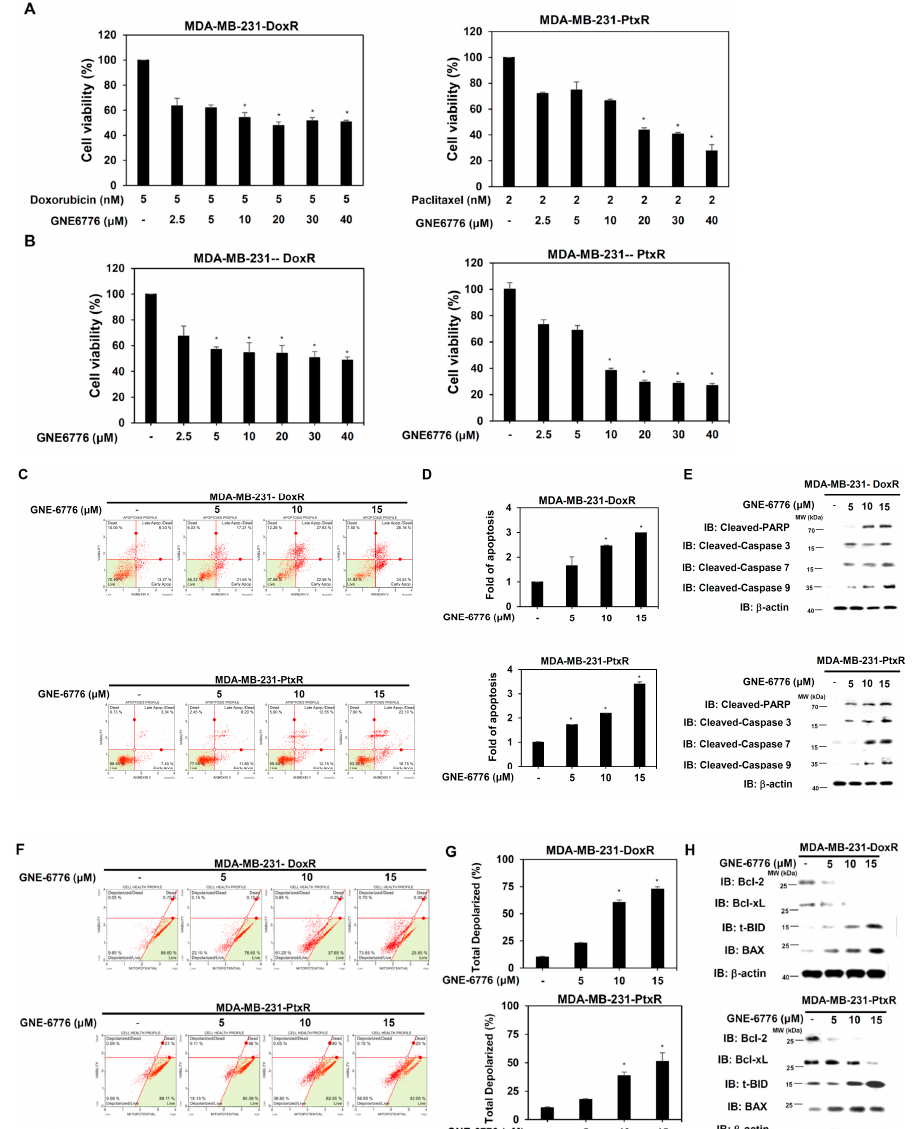
Figure 6. Effect of USP7 inhibitor on cell viability of chemoresistant TNBC. ( A ) The cell viability in MDA-MB-231-DoxR (left) and MDA-MB-231-PtxR (right) cells treated with serial doses of USP7 in- hibitor (GNE-6776) combined with doxorubicin or paclitaxel, respectively. ( B ) The cell viability of MDA-MB-231-DoxR (left) and MDA-MB-231-PtxR (right) cells treated with serial doses of USP7 in- hibitor (GNE-6776). ( C ) Apoptotic levels in MDA-MB-231-DoxR (upper) and MDA-MB-231-PtxR (lower) cells under serial doses of GNE-6776 treatment, assessed performing Annexin V-dependent flow cytometry assays. ( D ) Analysis for apoptosis of GNE-6776 treated-MDA-MB-231-DoxR (upper) and MDA-MB-231-PtxR (lower) cells. ( E ) Expressions of cleaved caspase family members in MDA- MB-231-DoxR (upper) and MDA-MB-231-PtxR (lower) cells under GNE-6776 treatment, by western blotting analysis with specific antibodies. ( F ) Levels of MMP in MDA-MB-231-DoxR (upper) and MDA-MB-231-PtxR (lower) cells under serial doses of GNE-6776, assessed using flow cytometry assays. ( G ) Analysis of total depolarized levels of MMP in GNE-6776-treated MDA-MB-231-DoxR (upper) and MDA-MB-231-PtxR (lower) cells. ( H ) Expression of Bcl family members in MDA-MB- 231-DoxR (upper) and MDA-MB-231-PtxR (lower) cells under serial doses of GNE-6776, by western blot analysis with specific antibodies. Data are represented as the mean ± SEM of biological triplicate experiments. * p < 0.05, compared with cells with steady concentration of doxorubicin and paclitaxel, respectively.